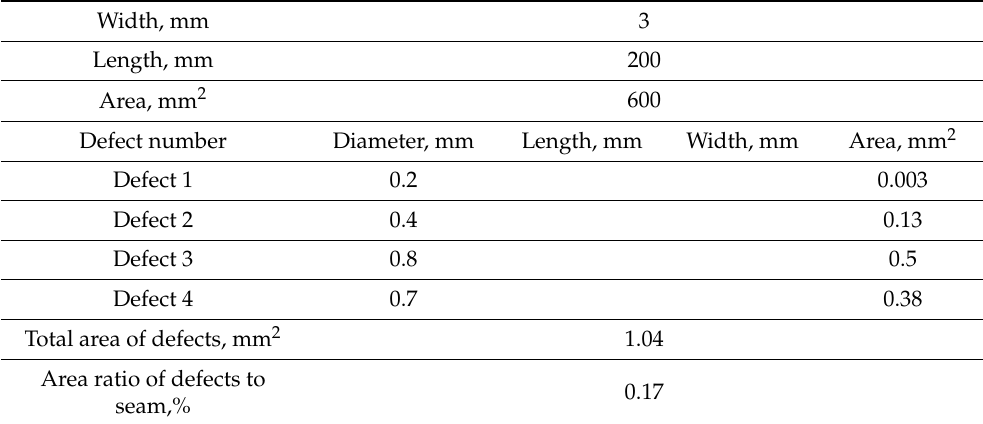
Table 5. Calculation of the area ratio of defects to the seam.